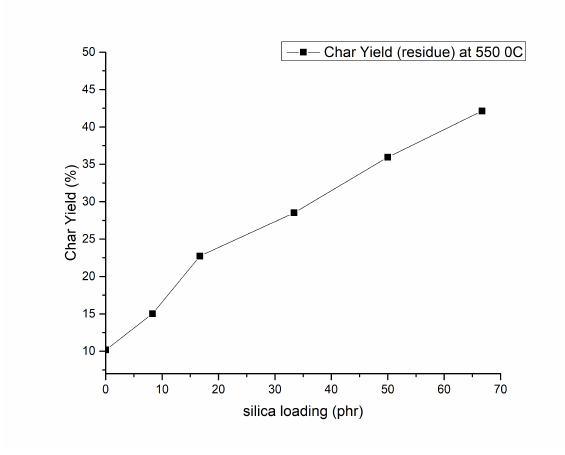
Figure 7: Char Yield at 550 ◦ C versus silica concentration